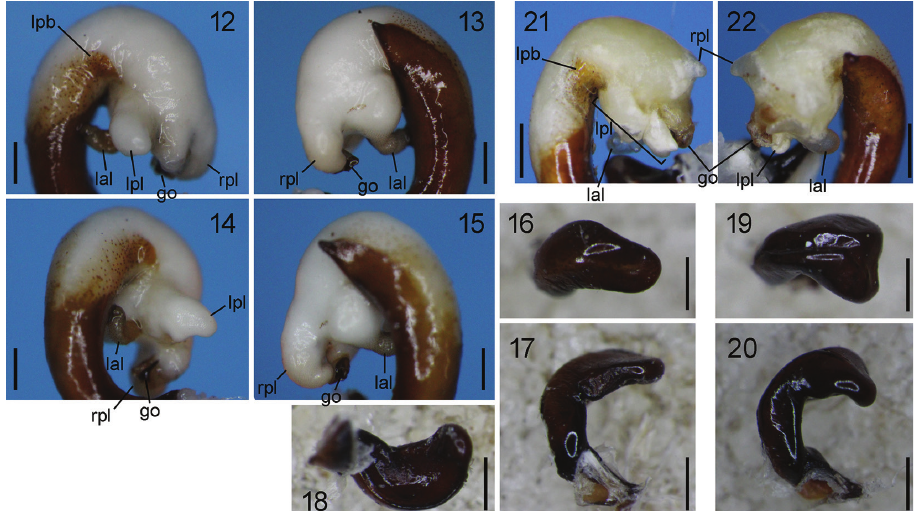
Figures 12–22. Male genitalia of species of the macrogenys species group. Left lateral view ( 12 ), right lateral view ( 13 ), left dorsolateral view ( 14 ), and right dorsolateral view ( 15 ) of endophallus of P. shin- bodakensis sp. n., holotype. Dorsal view of apical part ( 16 ), left lateral view ( 17 ), and ventral view of apical part ( 18 ) of right paramete of P. shinbodakensis sp. n., holotype. Dorsal view of apical part ( 19 ) and left lateral view ( 20 ) of right paramete of P. falcispinus from the type locality. Left lateral view ( 21 ) and right lateral view ( 22 ) of endophallus of P. tateishiyamanus sp. n., holotype. go: gonopore; lal: left apical lobe; lpb: left pigmented band; lpl: left preapical lobe; rpl: right preapical lobe. Scale bar = 0.5 mm. Pronotum cordate, notably flat, widest at apical 1/5. Lateral margins arcuate on apical 2/3, slightly sinuate on basal 1/3; two marginal setae on each lateral side, an- terior setae near widest pronotal point and posterior setae near hind angles. Anterior margin emarginated, with curvature approximately the same as that of apical 2/3 of lateral margins; anterior angles notably pronounced in the female, less pronounced in the male. Posterior margin emarginated at median area, almost straight at lateral areas; hind angles right-angled. Median line impressed in the middle, reaching the posterior margin in the holotype male but not reaching both anterior and posterior margins in the paratype male and female; laterobasal impressions single, shallow. Elytra almost parallel-sided, less convex; shoulder distinct, but not denticulate; apices rounded; scutellar stria present, connected to stria 1 in the male specimens; in the paratype female, stria 1 disconnected at the level of the posterior end of the scutellar stria, where only the scutellar stria is connected to the other part of stria 1; one setigerous puncture on stria 1 at the level of the posterior end of the scutellum; two setigerous punctures on interval 3, anterior one slightly behind the middle and posterior one on apical 1/5–1/4, both adjoining stria 2. Hind wings completely atro- phied. Male sternum 7 slightly concave. Female first fore tarsomere without adhesive hairs on ventral